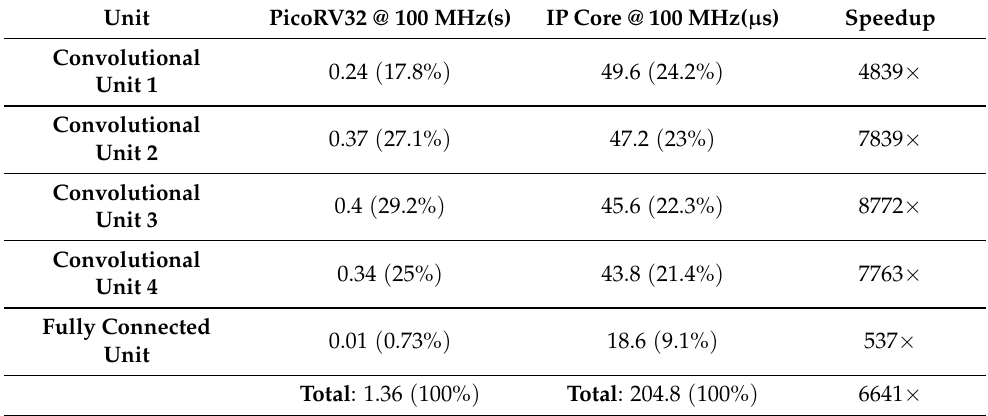
Table 13. Performance profiling of the ECG-ID-BNet inference in the proposed IP core @ 100 MHz compared with PicoRV32 @ 100 MHz (software only implementation, optimized with O3